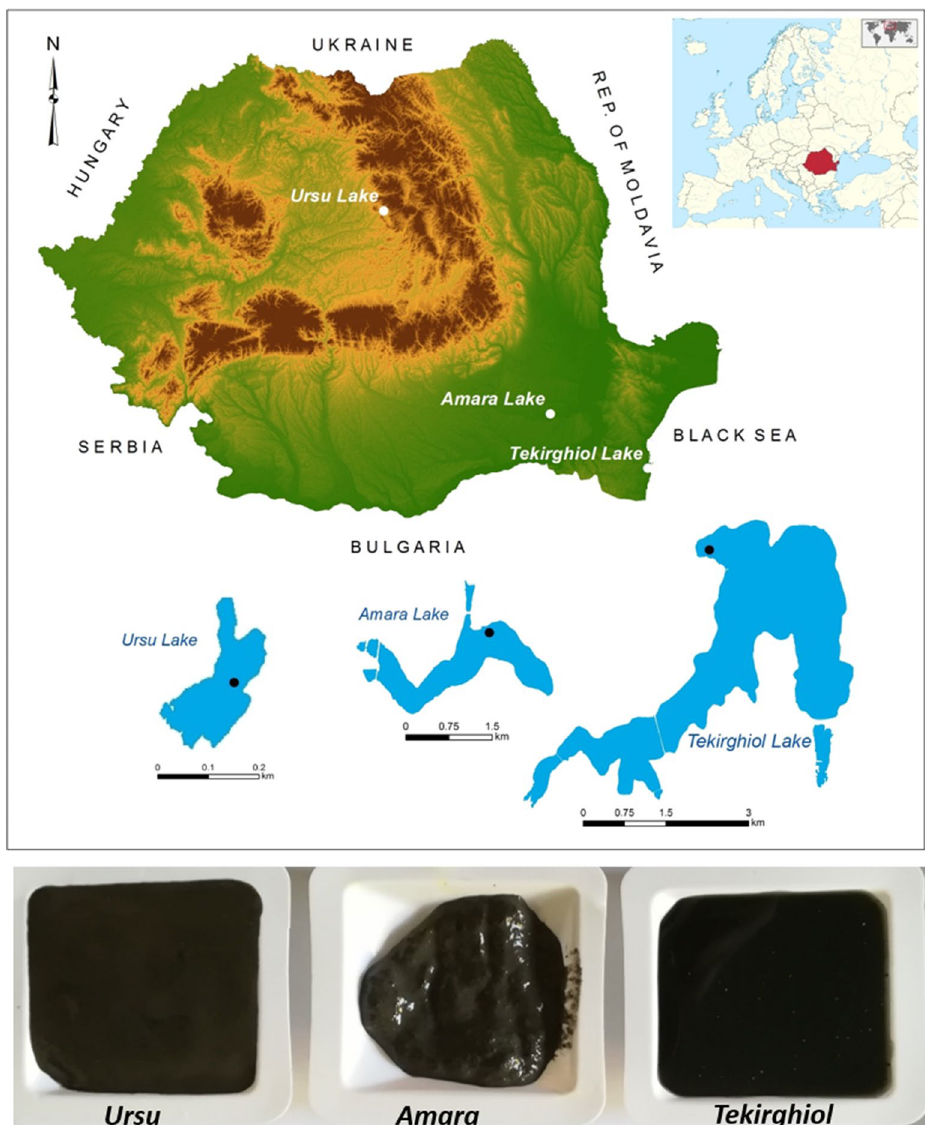
Figure 1. Geographic location and morphometric details of peloidogenous Ursu, Amara and Tekirghiol lakes, and the macroscopic aspect of the recent, dark-colored sapropels with curative use. The sampling points are indicated by black dots within the contour of each tested lake. ArcGIS 10.2 software was used to create the map (Environmental Systems Research Institute, USA, http:// www. esri. com). The map of Romania is based on the EU-DEM dataset (European Digital Elevation Model), and the contours of the lakes were obtained by digitization (Google